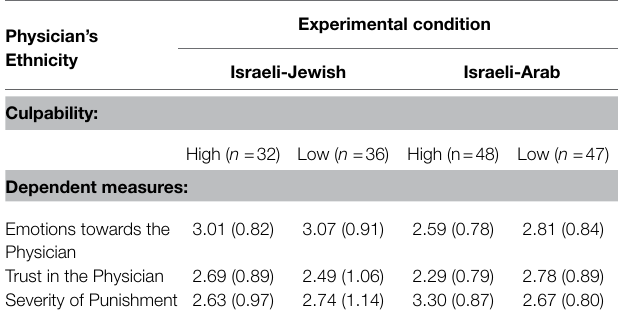
TABLE 1 | Means (SDs) of emotions towards the Physician, Trust in the Physician, and Severity of Punishment as a Function of Physician’s Ethnicity and Culpability.